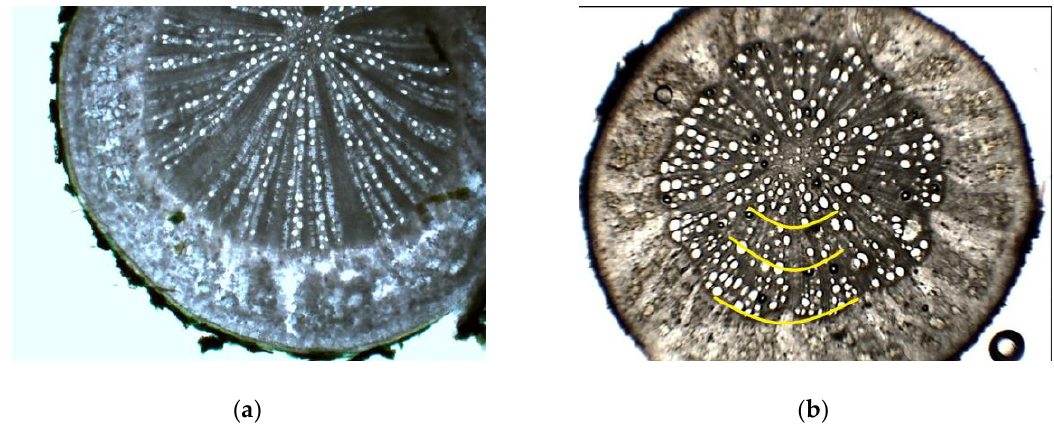
Figure 1. Light micrographs of ‘Oblačinska’ sour cherry — OV31 roots with secondary structure on a magnification of 40×. ( a ) Typical semi-ring porous xylem structure in the secondary root formed in the fogging irrigation system ( b ) Occurrence of growth ring-like xylem formations in the secondary roots formed in the natural habitat and collected from in vivo mother plants.